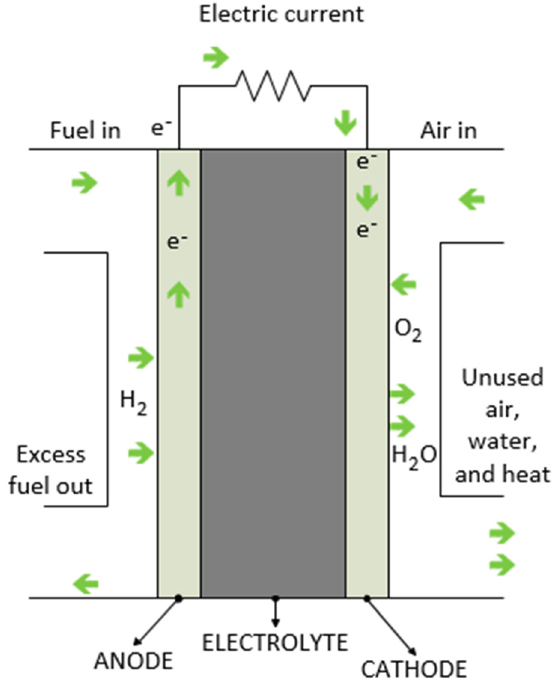
Figure 1. Proton exchange fuel cell diagram [7]. Reproduced with permission from Daud, W.R.W., Renew. Energy ; published by Elsevier, 2007.